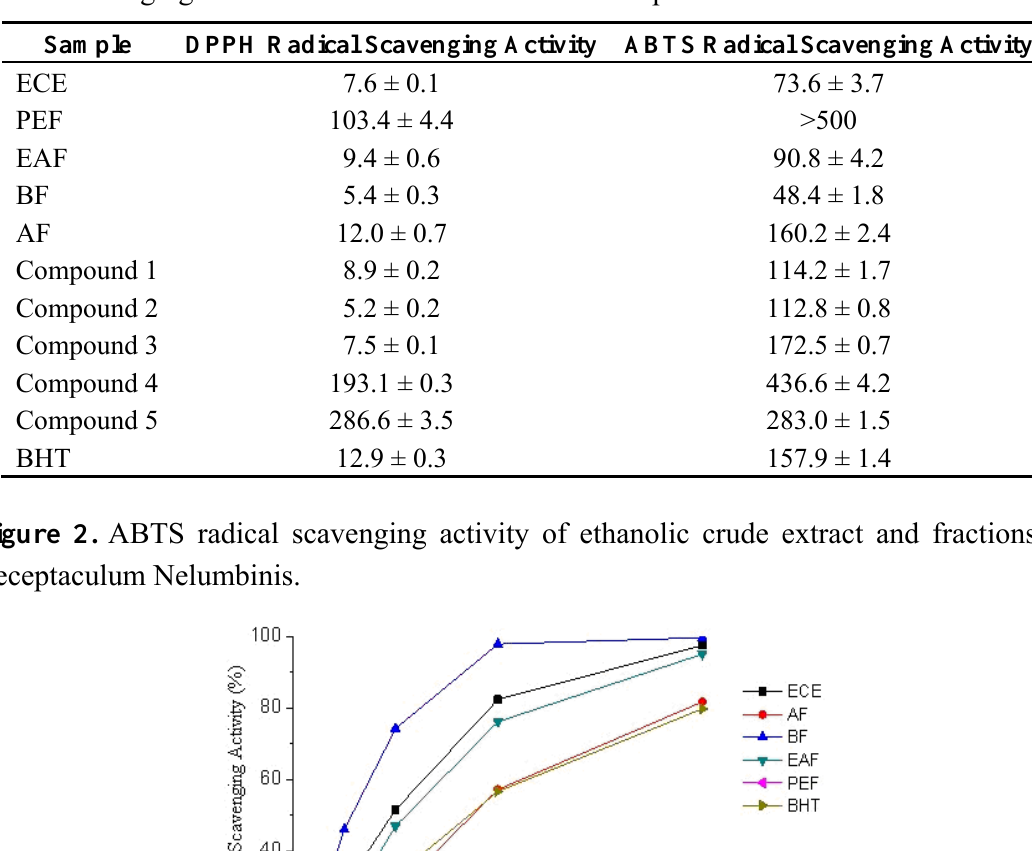
values (µg/mL) obtained in the antioxidant assays of DPPH scavenging and Table 2. IC 50 ABTS scavenging of crude extract and fractions of Receptaculum Nelumbinis.